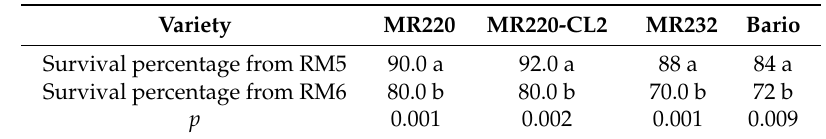
Table 3. Survival percentage of in vitro raised plantlets from RM5 (2 BAP+ 2 Kinetin+ 0.5 NAA) and RM6 (3 BAP+ 2 Kinetin+ 0.5 NAA) under natural environmental conditions (Malaysian condition) in pots after 2 weeks.